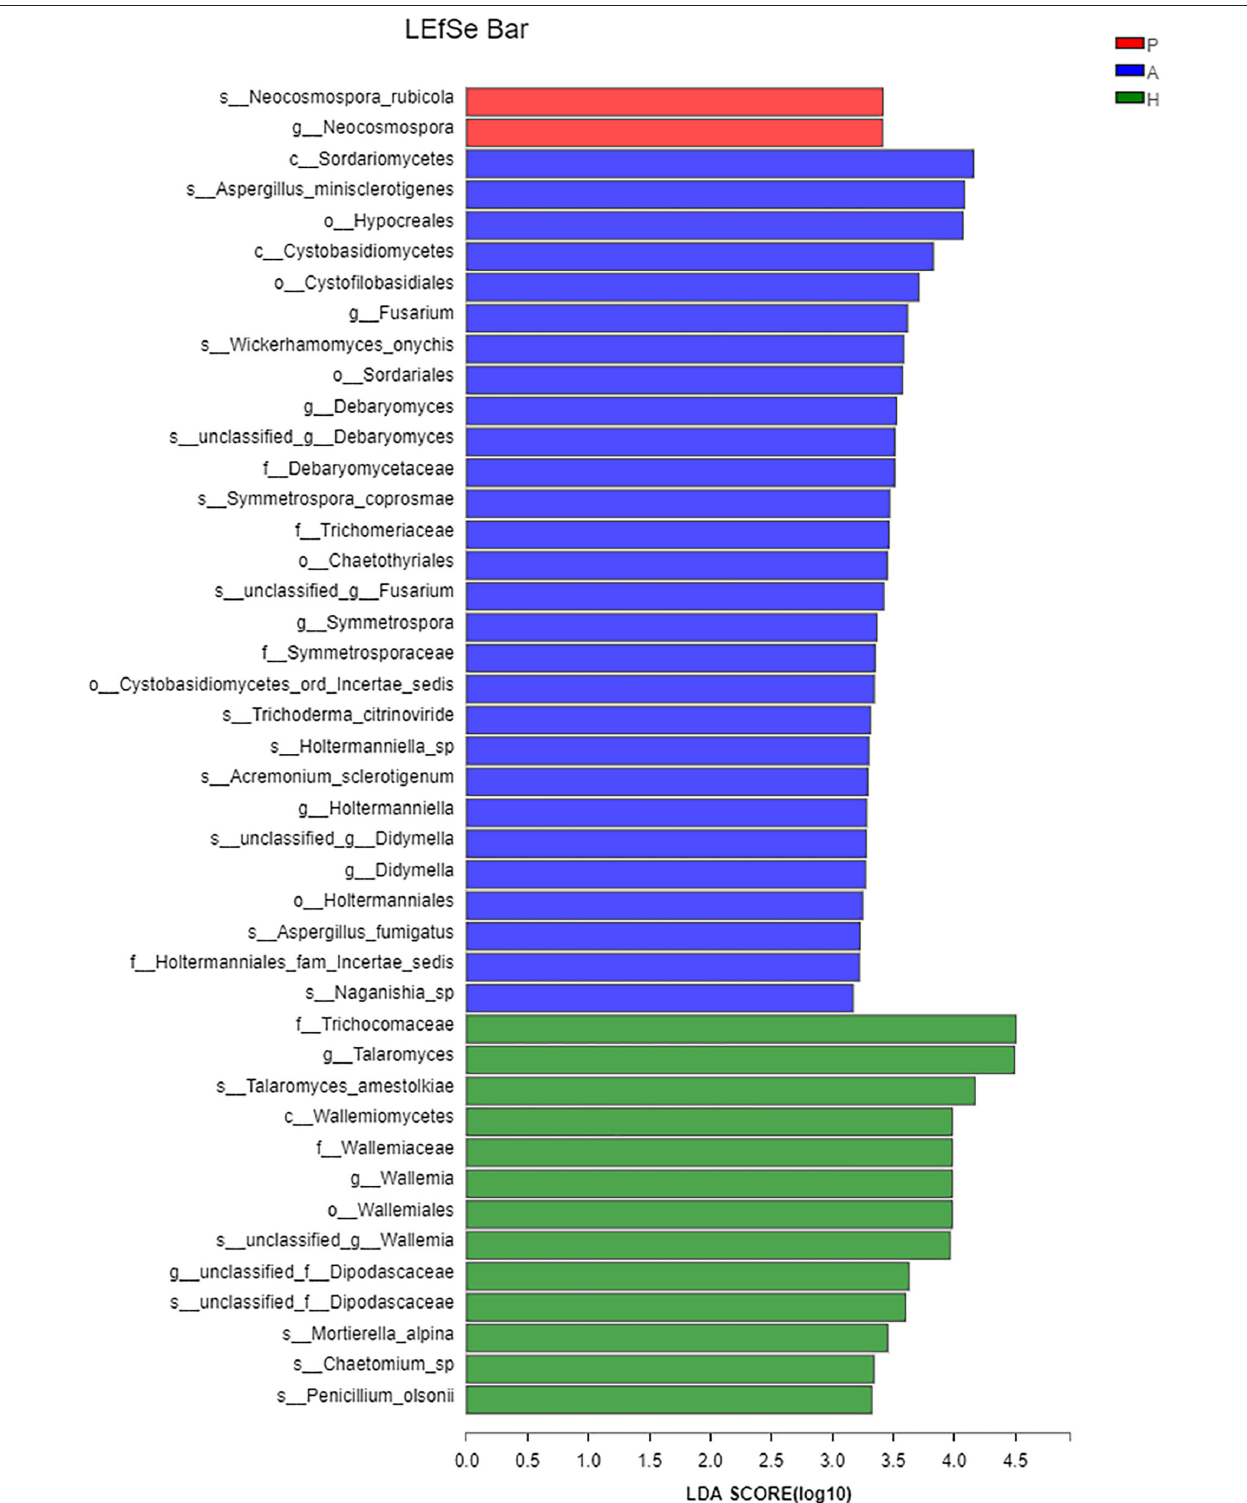
Frontiers in Microbiology |